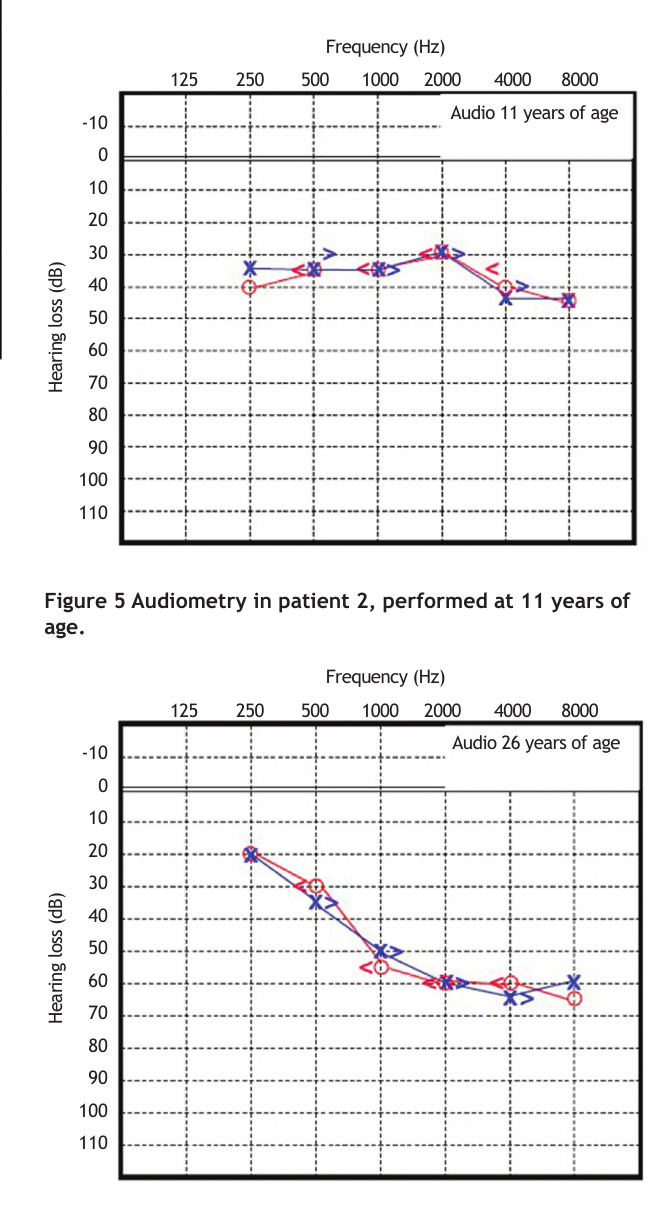
Figure 6 Audiometry in patient 2, performed at 26 years of age.